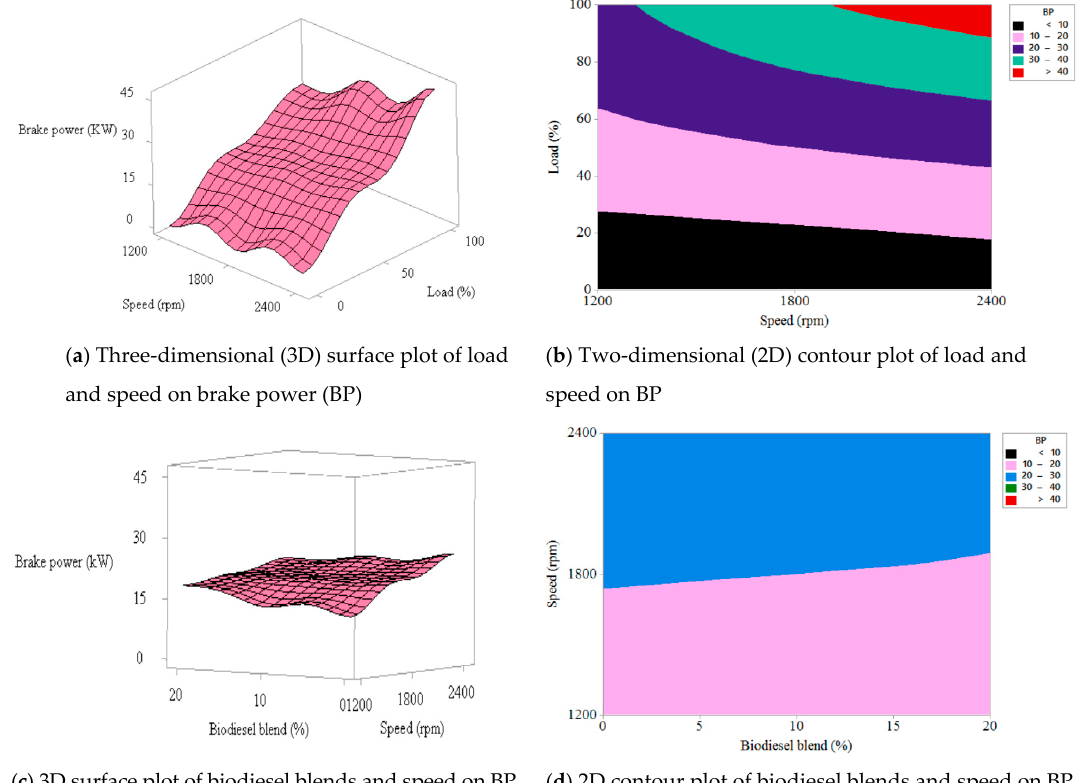
Figure 6. Combined effects of biodiesel blends, load, and speed on BP (kW).